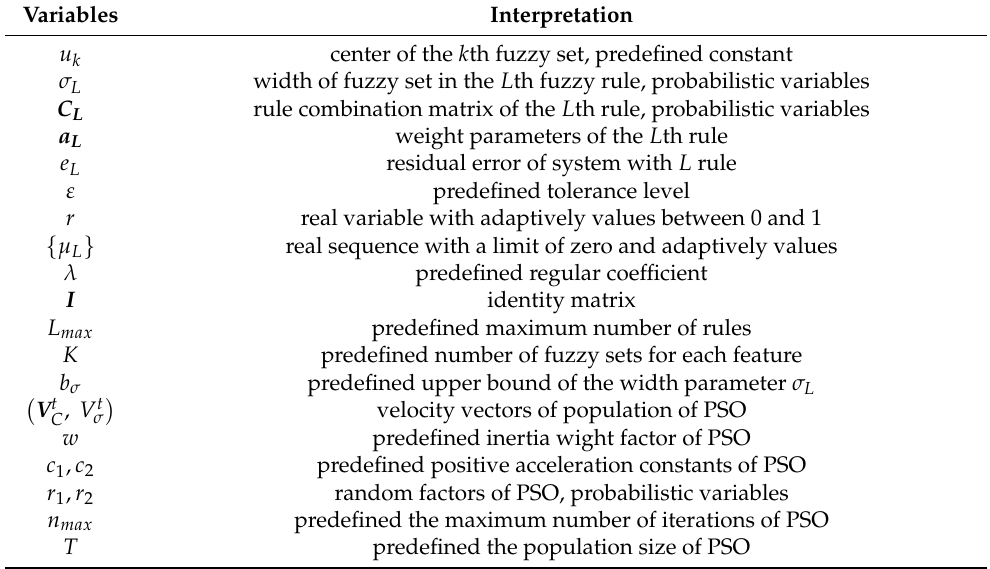
Table 2. Table of